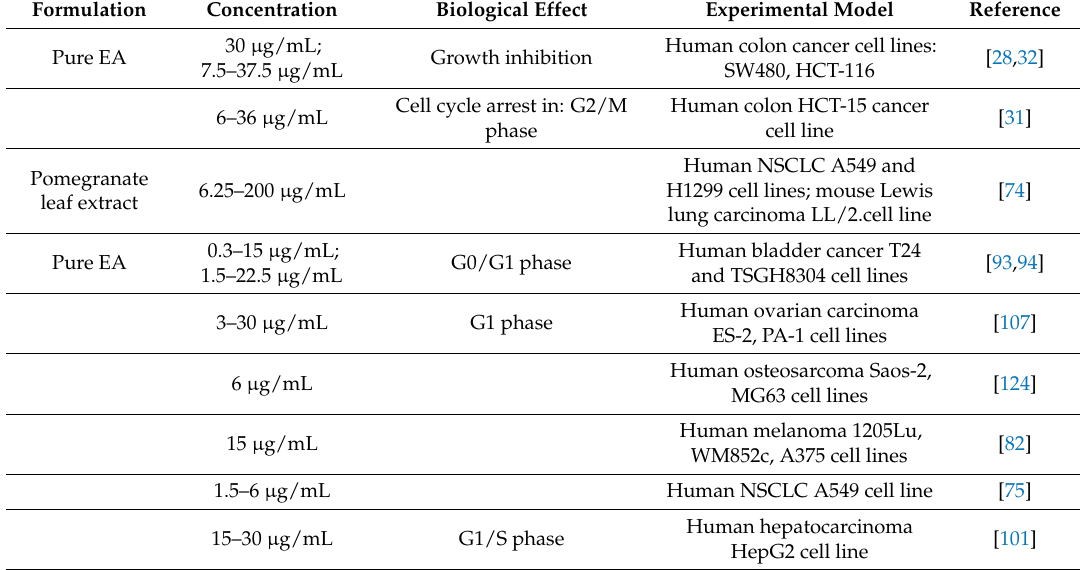
Table 2. In vitro experimental evidence of ellagic acid (EA) therapeutic